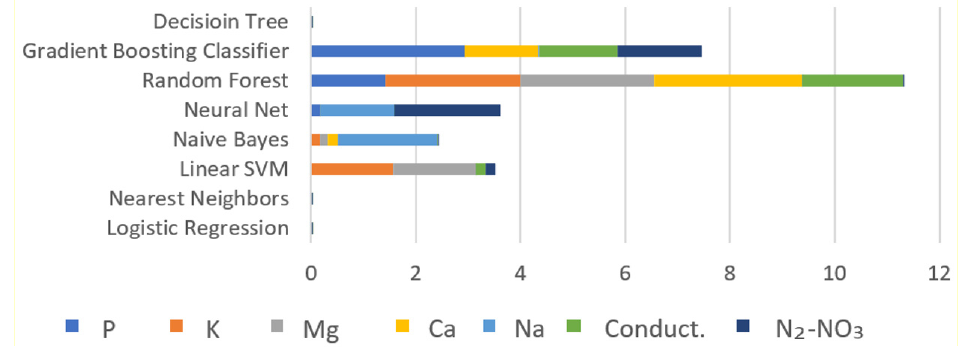
Figure 17. Training times (seconds) comparison among classifiers.